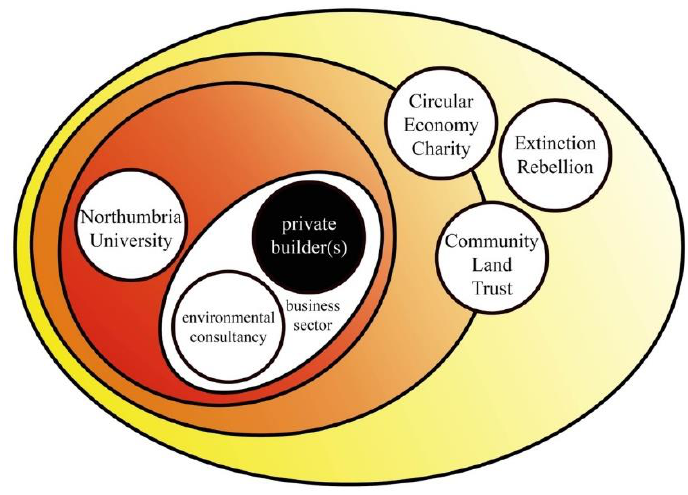
Figure 8. Mapping of Sustainable Development for Architecture and Built Environment Foundation Level 3 Module.